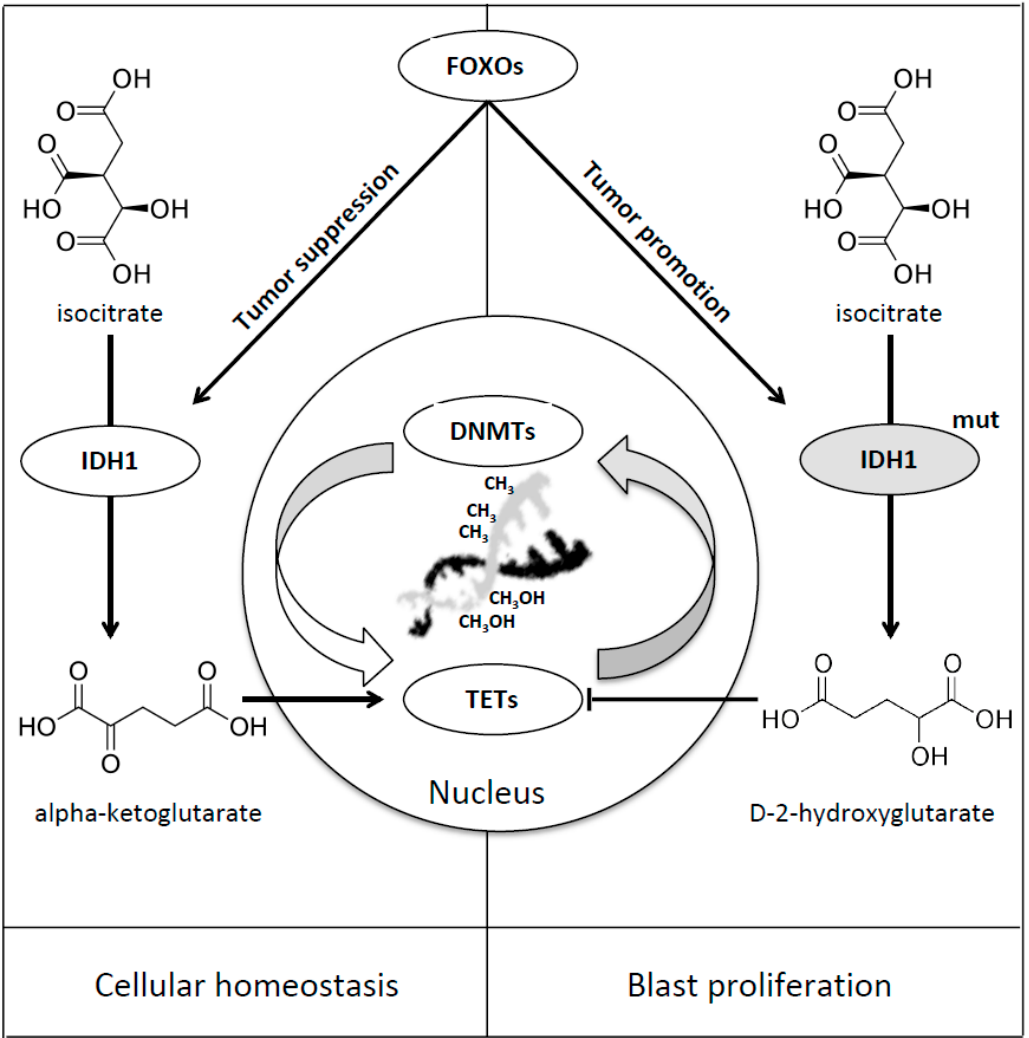
Figure 4. FOXOs mediated regulation of IDH1. IDH1 is directly regulated by FOXO transcription factors [49], taking part in the enzymatic reduction of isocitrate to alpha-ketoglutarate, ensuring cellular homeostasis, thus playing its tumor suppressive role (Left Panel). In case of IDH1 mutation FOXOs transcription factors enhance the function of IDH mutated enzyme and, as a result, lead to the accumulation of the D-2-hydroxyglutarate onco-metabolite and promote blast proliferation (Right Panel) [49].